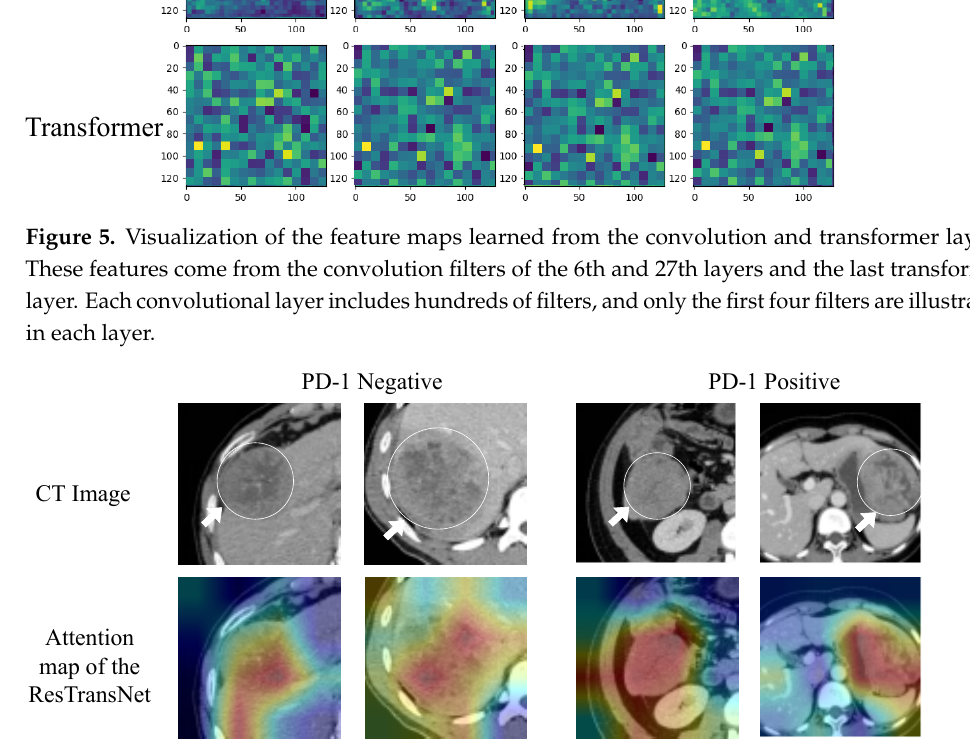
Figure 6. Visualization of the class activation map generated by the last transformer layer. Red denotes higher attention values, and the color blue denotes lower